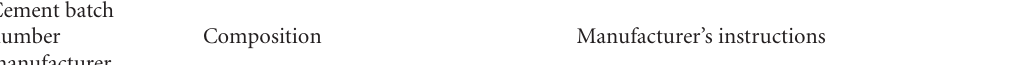
Table 1: Characteristics of the cements used and the manufacturers’ instructions.